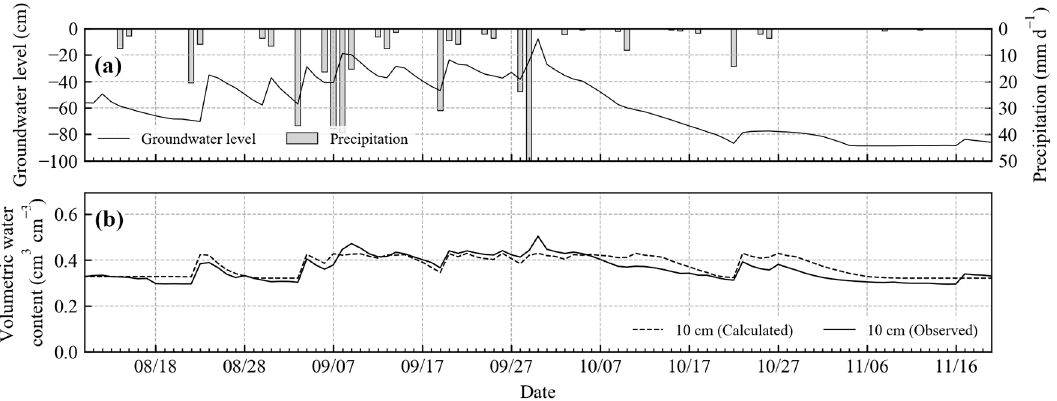
Figure 6. Volumetric water content in the validation plot in 2018. ( a ) Groundwater level and precipitation; ( b ) θ cal and θ obs at a depth of 10 cm. The maximum daily precipitation, 82.7 mm d − 1 , occurred on 29 September 2018.